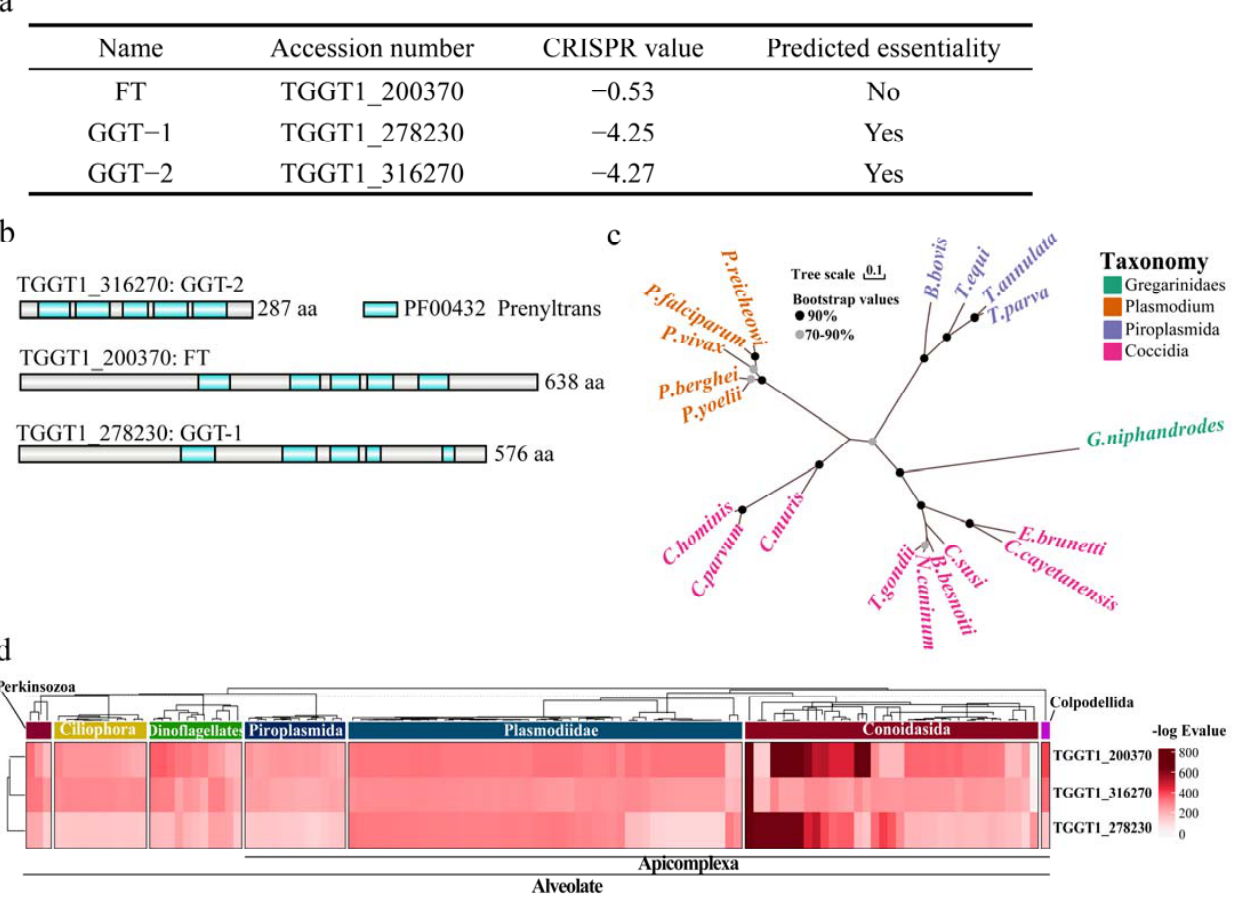
Figure 1. Conservation and phylogenetic analysis for FT, GGT-1 and GGT-2. ( a ) The information about FT, GGT-1 and GGT-2 could be obtained from the website (https://toxodb.org/toxo/app) (accessed on 2 June 2022). ( b ) Schematic diagram of domains in prenyl transferases. ( c ) Maximum likelihood tree presented the phylogenetic relationships of prenyl transferase homologs in diverse apicomplexans, and the bootstrap values of the branch greater than 70% were displayed. The scale bar indicated the genetic distance. ( d ) Heatmap indicating conservation of associated proteins among Alveolata. The tree dendrogram without meaningful branch lengths across these species and identi fi ed proteins were clustered according to Euclidean distance using the UPGMA method.